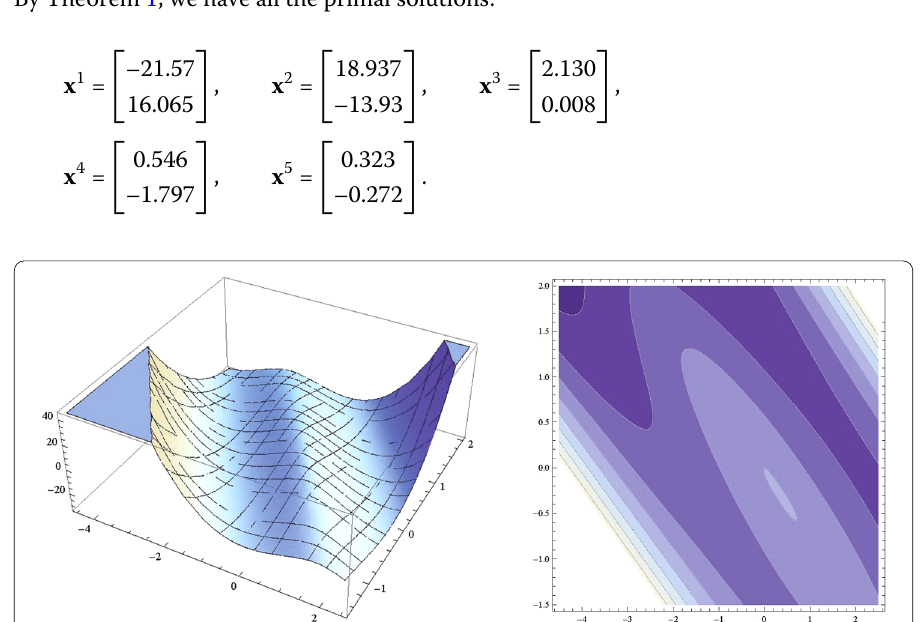
Figure 5 Graph of (cid:2) ( x ) and its contour for Example